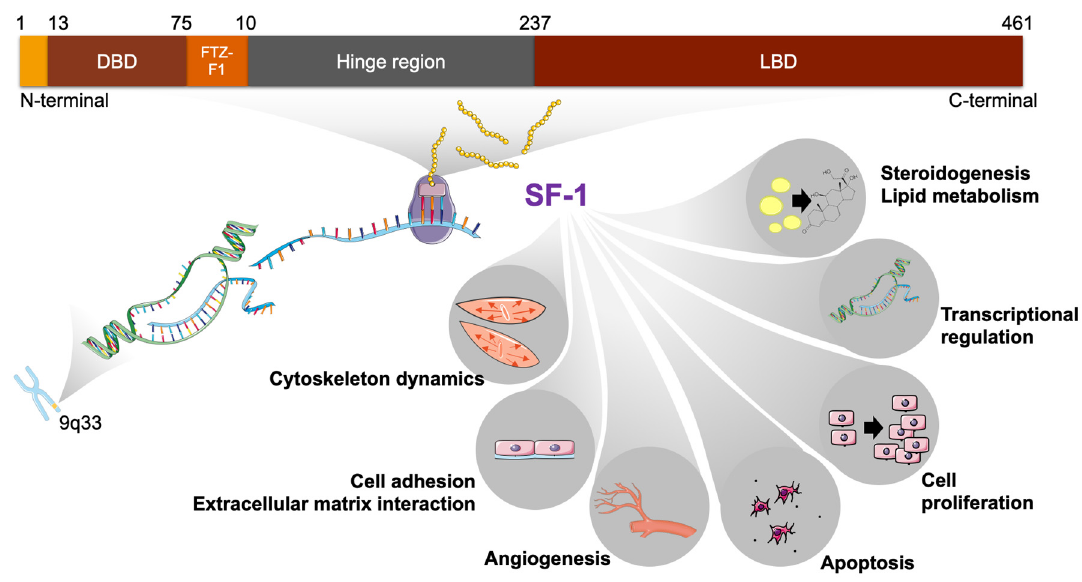
Figure 1. Structure of the human SF-1 protein and its target gene categories in tumor adrenocortical cells. The protein domains are shown and corresponding amino acid positions are indicated. SF-1 regulates several key cellular processes. DBD, DNA binding domain; FTZ-F1, FTZ-F1 box; LBD, ligand binding